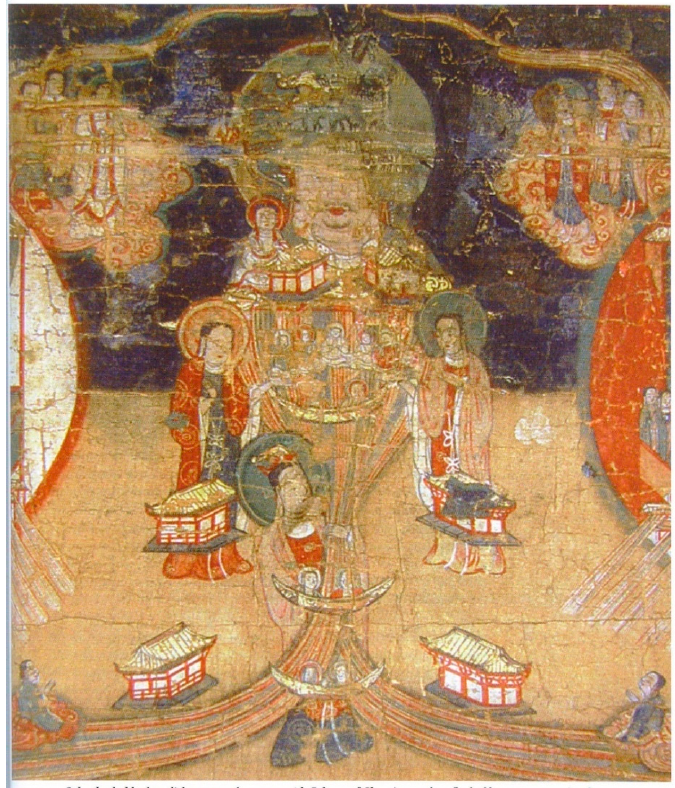
Figure 7. The Keeper of Splendor embraces light streams that merge with the Column of Glory (Gulácsi 2016, Figure 6/40 [p. 455]).